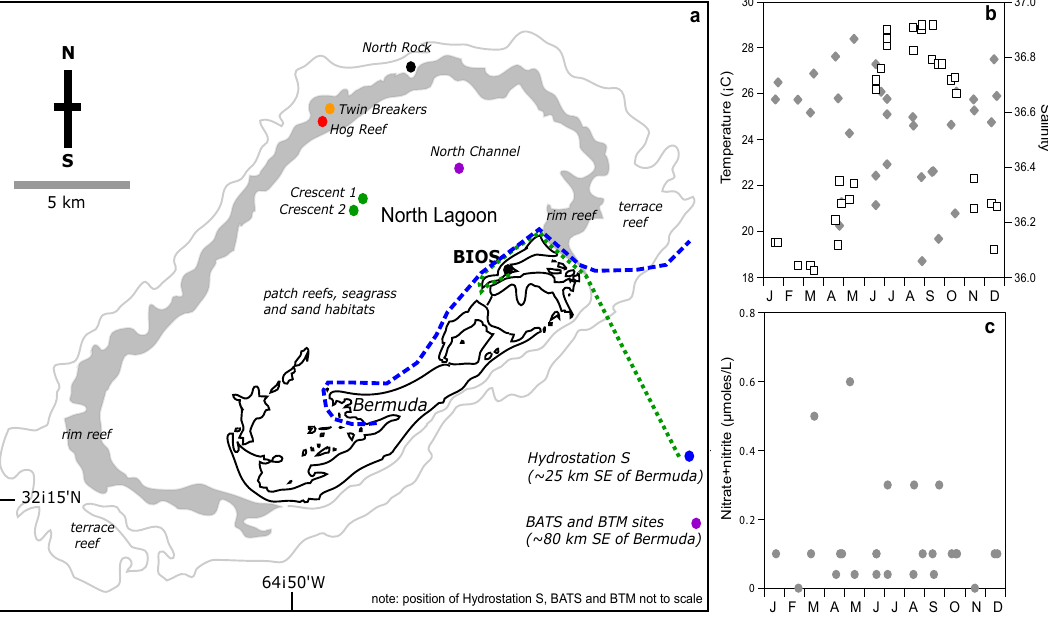
Fig. 1. Location of rim and terrace reefs of Bermuda, the North Lagoon and island of Bermuda, and seasonal changes in temperature, salinity and nitrate+nitrite. (a) Two reef sites, Hog Reef (red symbol) and Twin Breakers (orange symbol), were chosen as representative of the broad rim reefs that enclose lagoonal waters of the North Lagoon. The North Lagoon contains patch coral reefs and extensive sand area, with two sites (Crescent 1 and 2; green symbol) representative of patch reefs. The track of weekly underway, shipboard sampling from the R/V Atlantic Explorer (green dashed line) and M/V Oleander (blue dashed line) are shown. The offshore Hydrostation S (blue symbol), Bermuda Atlantic Time-series Study (BATS; purple symbol) and Bermuda Testbed Mooring (BTM) sites are also shown (Bates, 2007). The CARIOCA p CO 2 buoy was deployed at Hog Reef from 2002 to 2003; (b) seasonal changes in temperature ( ◦ C; open squares) and salinity (grey diamond) at the North Channel site in the North Lagoon from 2001 to 2006, and; (c) seasonal changes in nitrate+nitrite (µmoleskg − 1 ) at the North Channel site in the North Lagoon from 2001 to 2006. North Channel WQMP data courtesy of Drs Richard Owen and Ross Jones (MEP, 2006; http://www.bios-mep.info/; executive